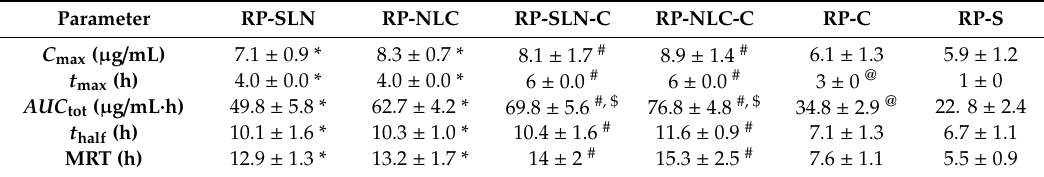
Table 10. Pharmacokinetic parameters of RP from RP-SLN, RP-NLC, RP-S and RP-SLN-C, RP-NLC-C, RP-C formulations after single dose oral and transdermal administration, respectively, in Wistar rats (mean ± SD, n =